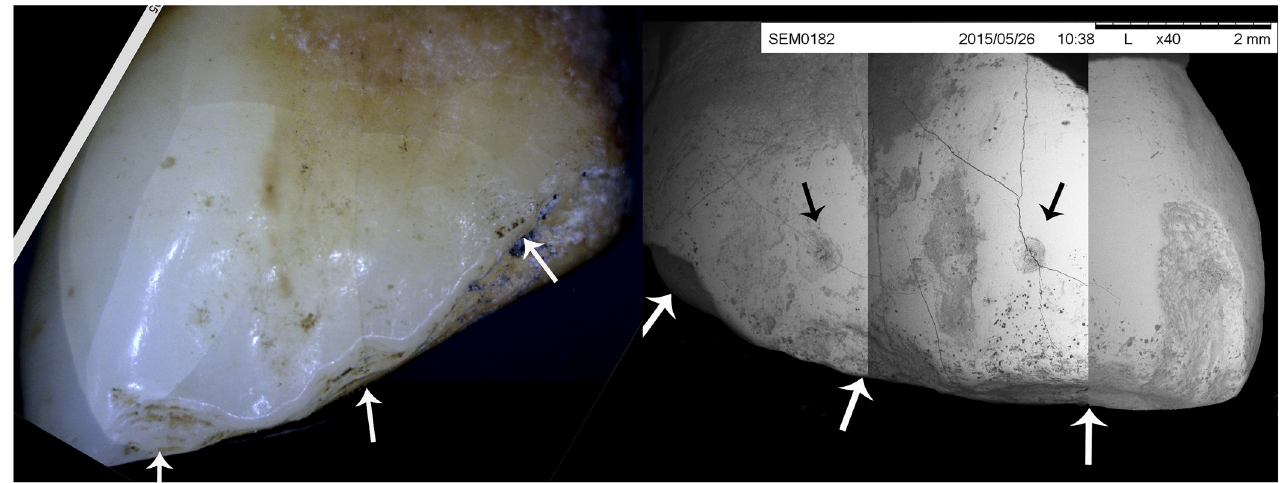
Fig 3. Labial surface of the maxillary central incisors of E-105. Labial surface of the maxillary central incisors of E-105a) under 20x magnification captured by digital microscope; b) composite image captured by an SEM microscope at 80x magnification. White arrows indicate the site of conchoidal fractures; black arrows indicate the pits on the enamel above the conchoidal fractures.